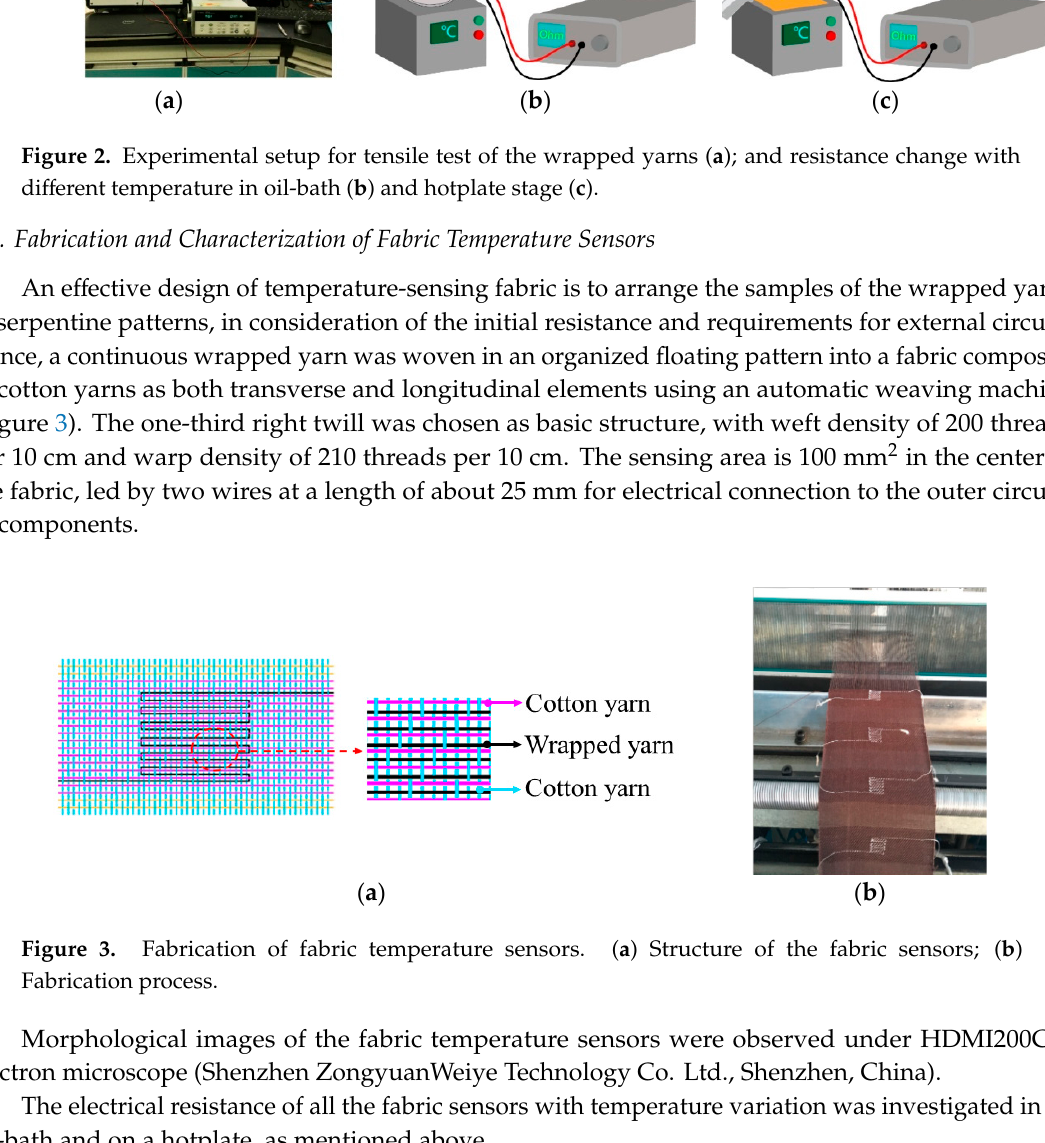
( a ) Structure of the fabric sensors; ( b )